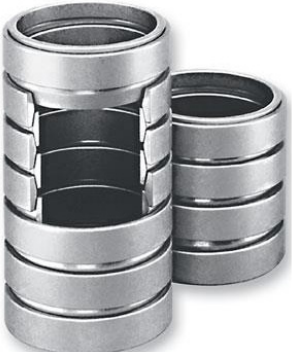
Figure 1. Ring spring.